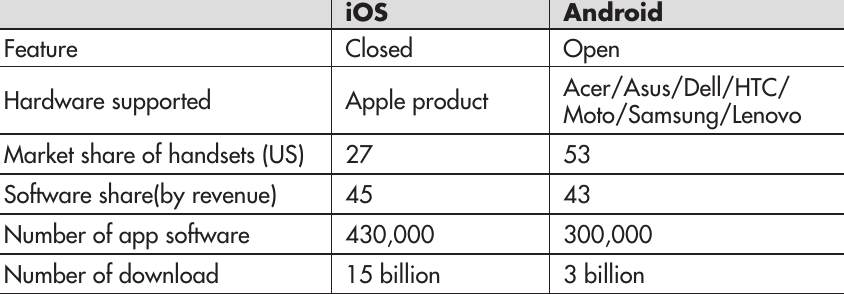
Table 5 Comparison between Apple (iOS) and Google (Android) iOS Android Feature Closed